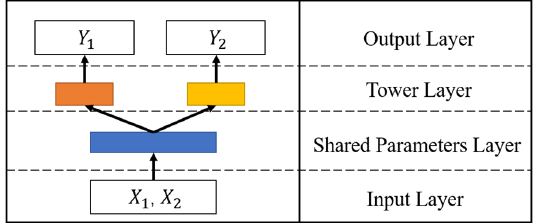
Figure 1. The basic framework of multi-task learning. The blue part represents the shared parameter layer, and the orange and yellow parts represent the models for different tasks forming the tower layer.